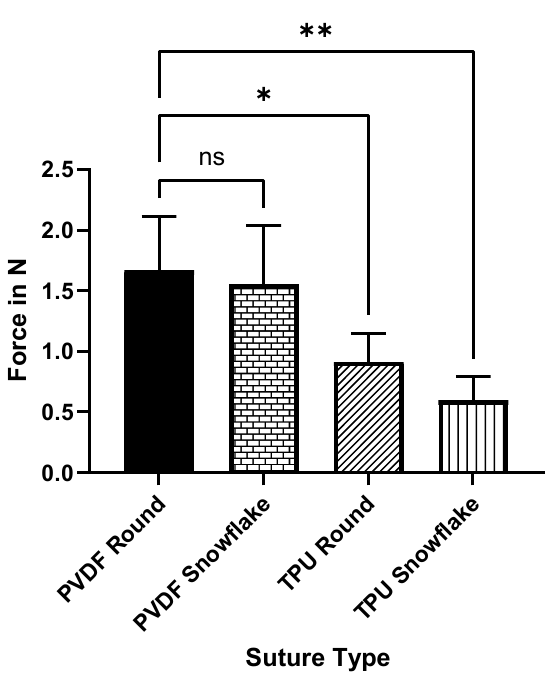
Figure 6. Maximum tension difference between peak suture tension and suture tension steady state after 15 min. Both TPU threads showed a significantly reduced tension loss vs. round PVDF sutures.